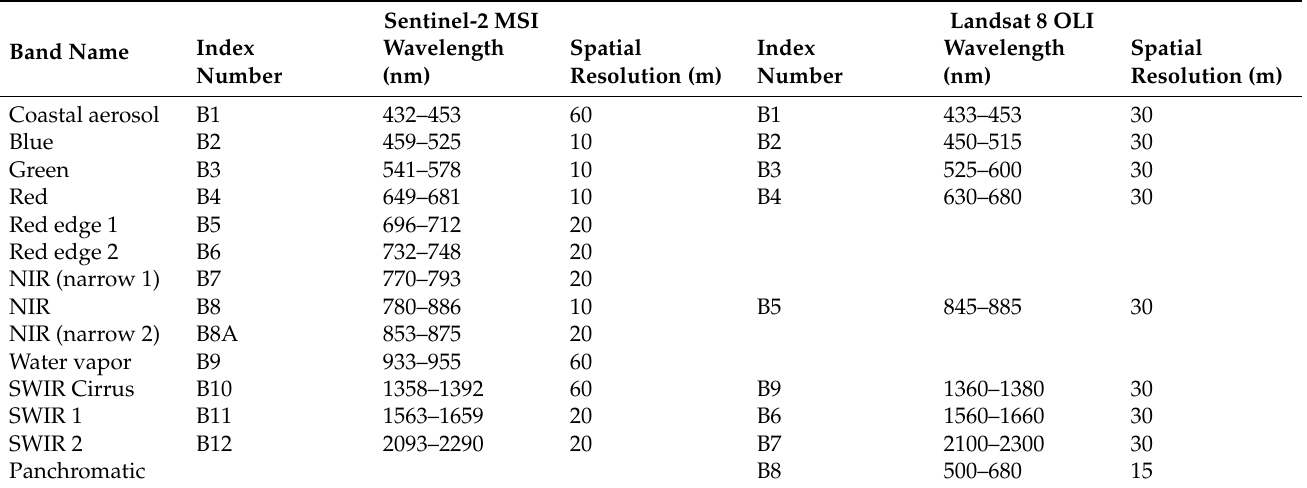
Table 2. Comparison of Sentinel-2 MultiSpectral Instrument (MSI) and Landsat 8 Operational Land Imager (OLI) radiometric and spatial resolutions of spectral